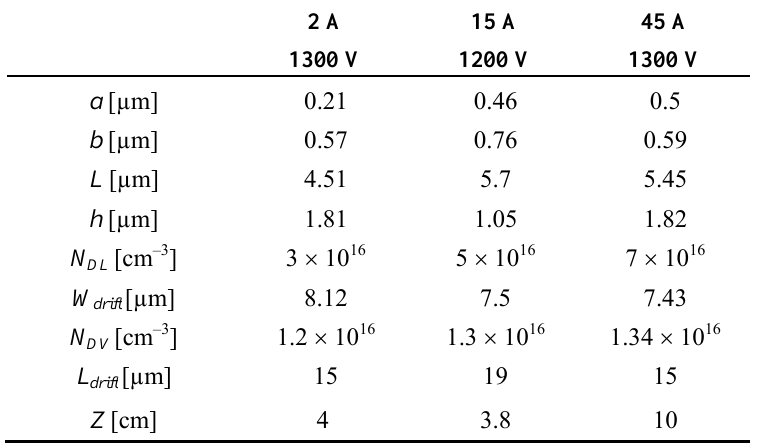
Table 1. Optimal design parameter set for three SiC JFETs